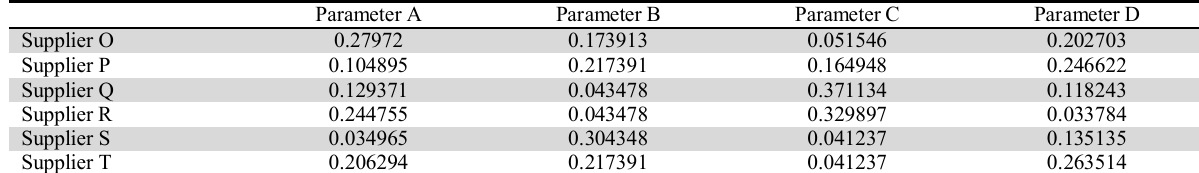
Normalized table of effects of choosing each supplier on PRs of final product